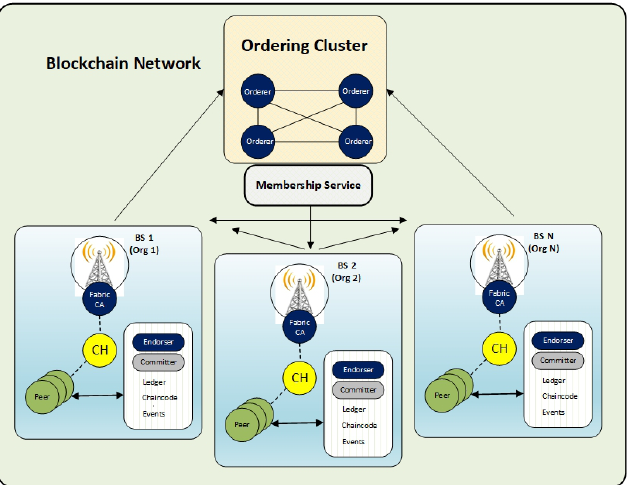
Figure 4. The network architecture of the IoT-enabled cellular system combined with the blockchain technology and smart